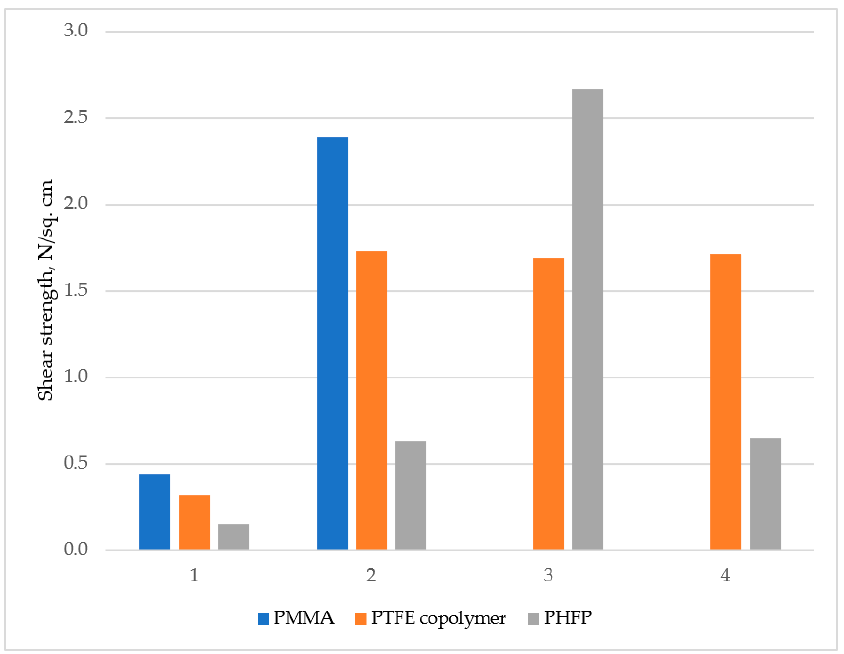
Figure 10. Sheer strength of adhesive systems with abovementioned polymers: ( 1 )—untreated aluminum foils, ( 2 )—anodized aluminum foils, ( 3 )—anodized aluminum foils with 1,1,1,2,2,3,3-heptafluoro-4,4-bis(trifluoromethyl)pentyltriethoxysilane modification, ( 4 )—anodized aluminum foils with 2,2,3,3,4,4,5,5,6,6,6-Undecafluoro-N-(3-methyldiethoxysilylpropyl)hexanamide modification.